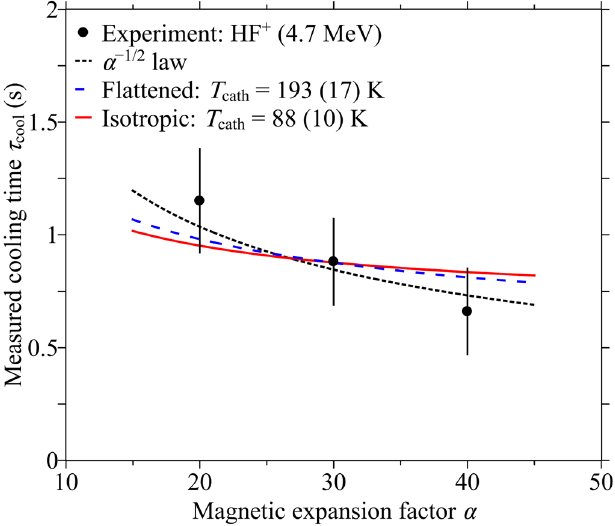
FIG. 6. Cooling time τ for HF þ at 4.7-MeV ( 233 keV = cool nucleon) as a function on the expansion factor α of the electron beam, with other Target parameters held fixed. Only the hori- zontal component of the betatron motion has been analyzed. The data is compared to a simplified α − 1 = 2 -law (short-dashed black curve) and to the models from Eqs. (9) (long-dashed blue) and (8) (solid red) as described in the